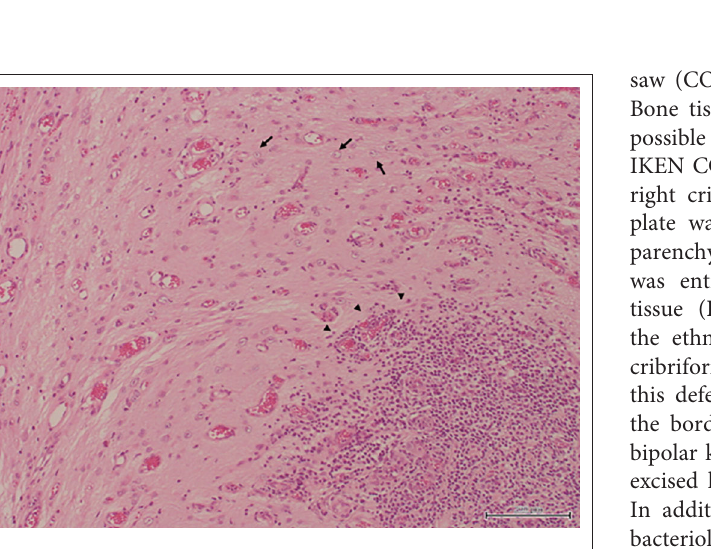
FIGURE 3 | The resected specimen contained nerve tissues, leading to a diagnosis of meningoencephalocele. An increase in astrocytes and infiltration of inflammatory cells which consisted of many lymphocytes, plasmacytes, macrophages and a few neutrophils were recognized in the specimen (H&E stain, bar = 200 µ